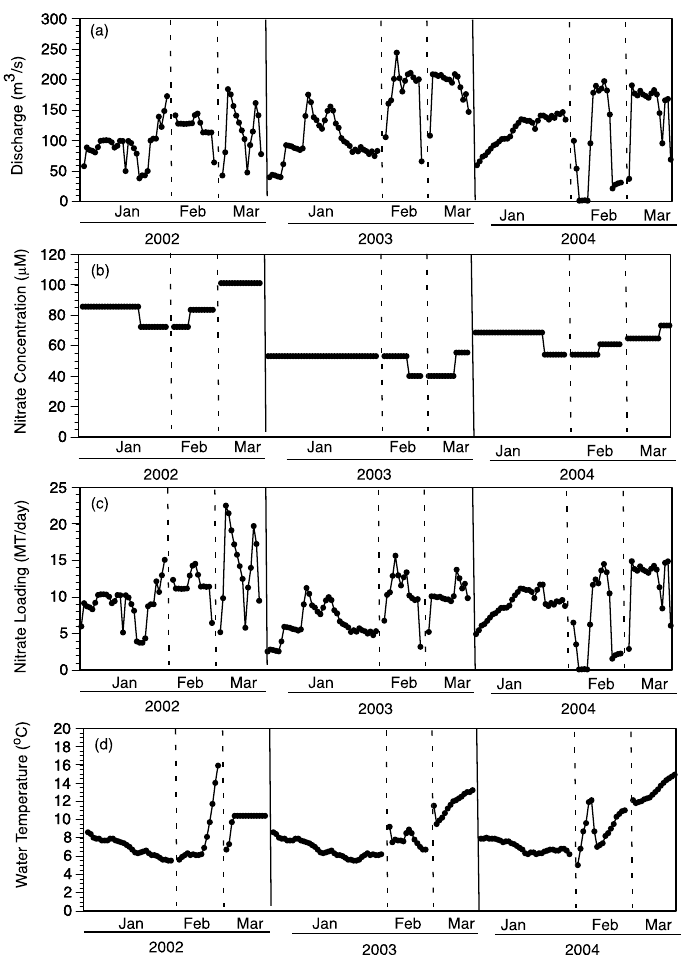
Figure 10. Description of three pulses in January, February, and March during each year of 2002, 2003, and 2004 that were analyzed for fate of nitrate (NO 3 − ) in the upper Breton Sound outfall area of Caernarvon freshwater diversion. ( a ) Discharge each day of the diversion pulse (m 3 /s). ( b ) Nitrate concentration estimated in the water introduced from river into the upper Breton Sound ( μ M). ( c ) Nitrate loading (MT/day) into upper Breton Sound based on daily discharge ( a ) and nitrate concentration ( μ M). ( d ) Water temperature recorded at Caernarvon freshwater diversion from the outfall channel (°C).